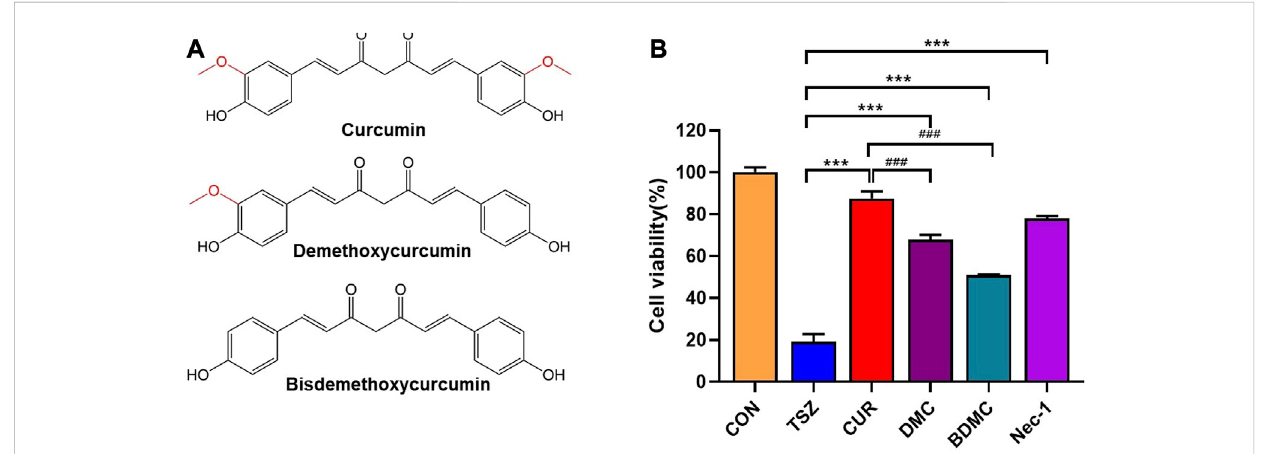
Theanti-necroptoticactivitiesofcurcumincompoundswerecompared. (A) Thechemicalstructuralformulaofcurcumin,dimethoxycurcumin,and bisdemethoxycurcumin. (B) HT-29 cells were pretreated with curcumin, demethoxycurcumin, and bisdemethoxycurcumin, Necrostain-1 was used as